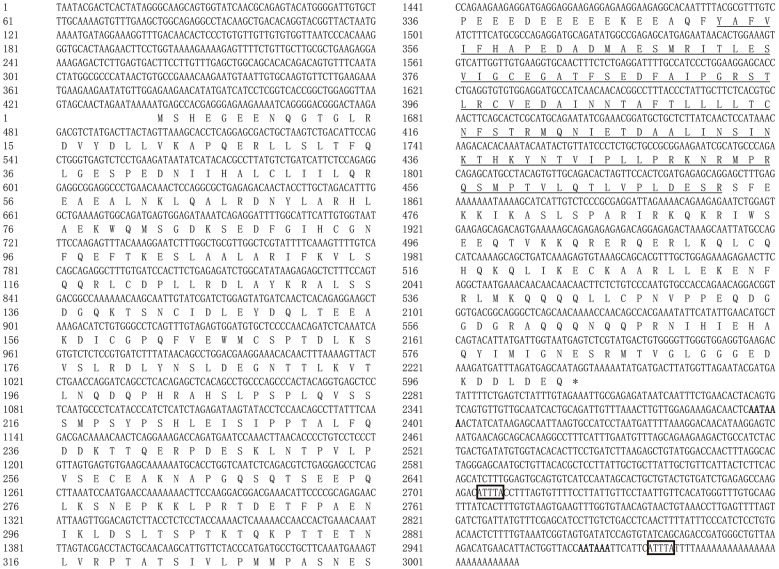
Nucleotide and deduced amino acid sequences of TRIF in large yellow croaker. The TIR domain is underlined. The two poly(A) signals (AATAAA) are highlighted in bold, and the two instability signals (ATTTA) are marked by boxes.